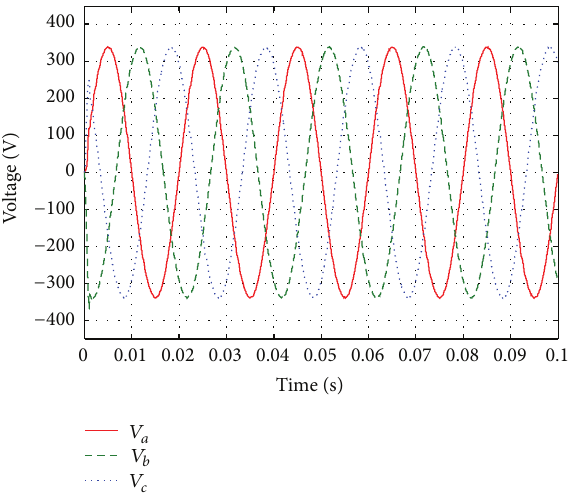
Figure 20: Output voltage waveforms (i.e., 𝑉 𝑎 , 𝑉 𝑏 , and 𝑉 𝑐 ) of the three-phase inverter with nonlinear